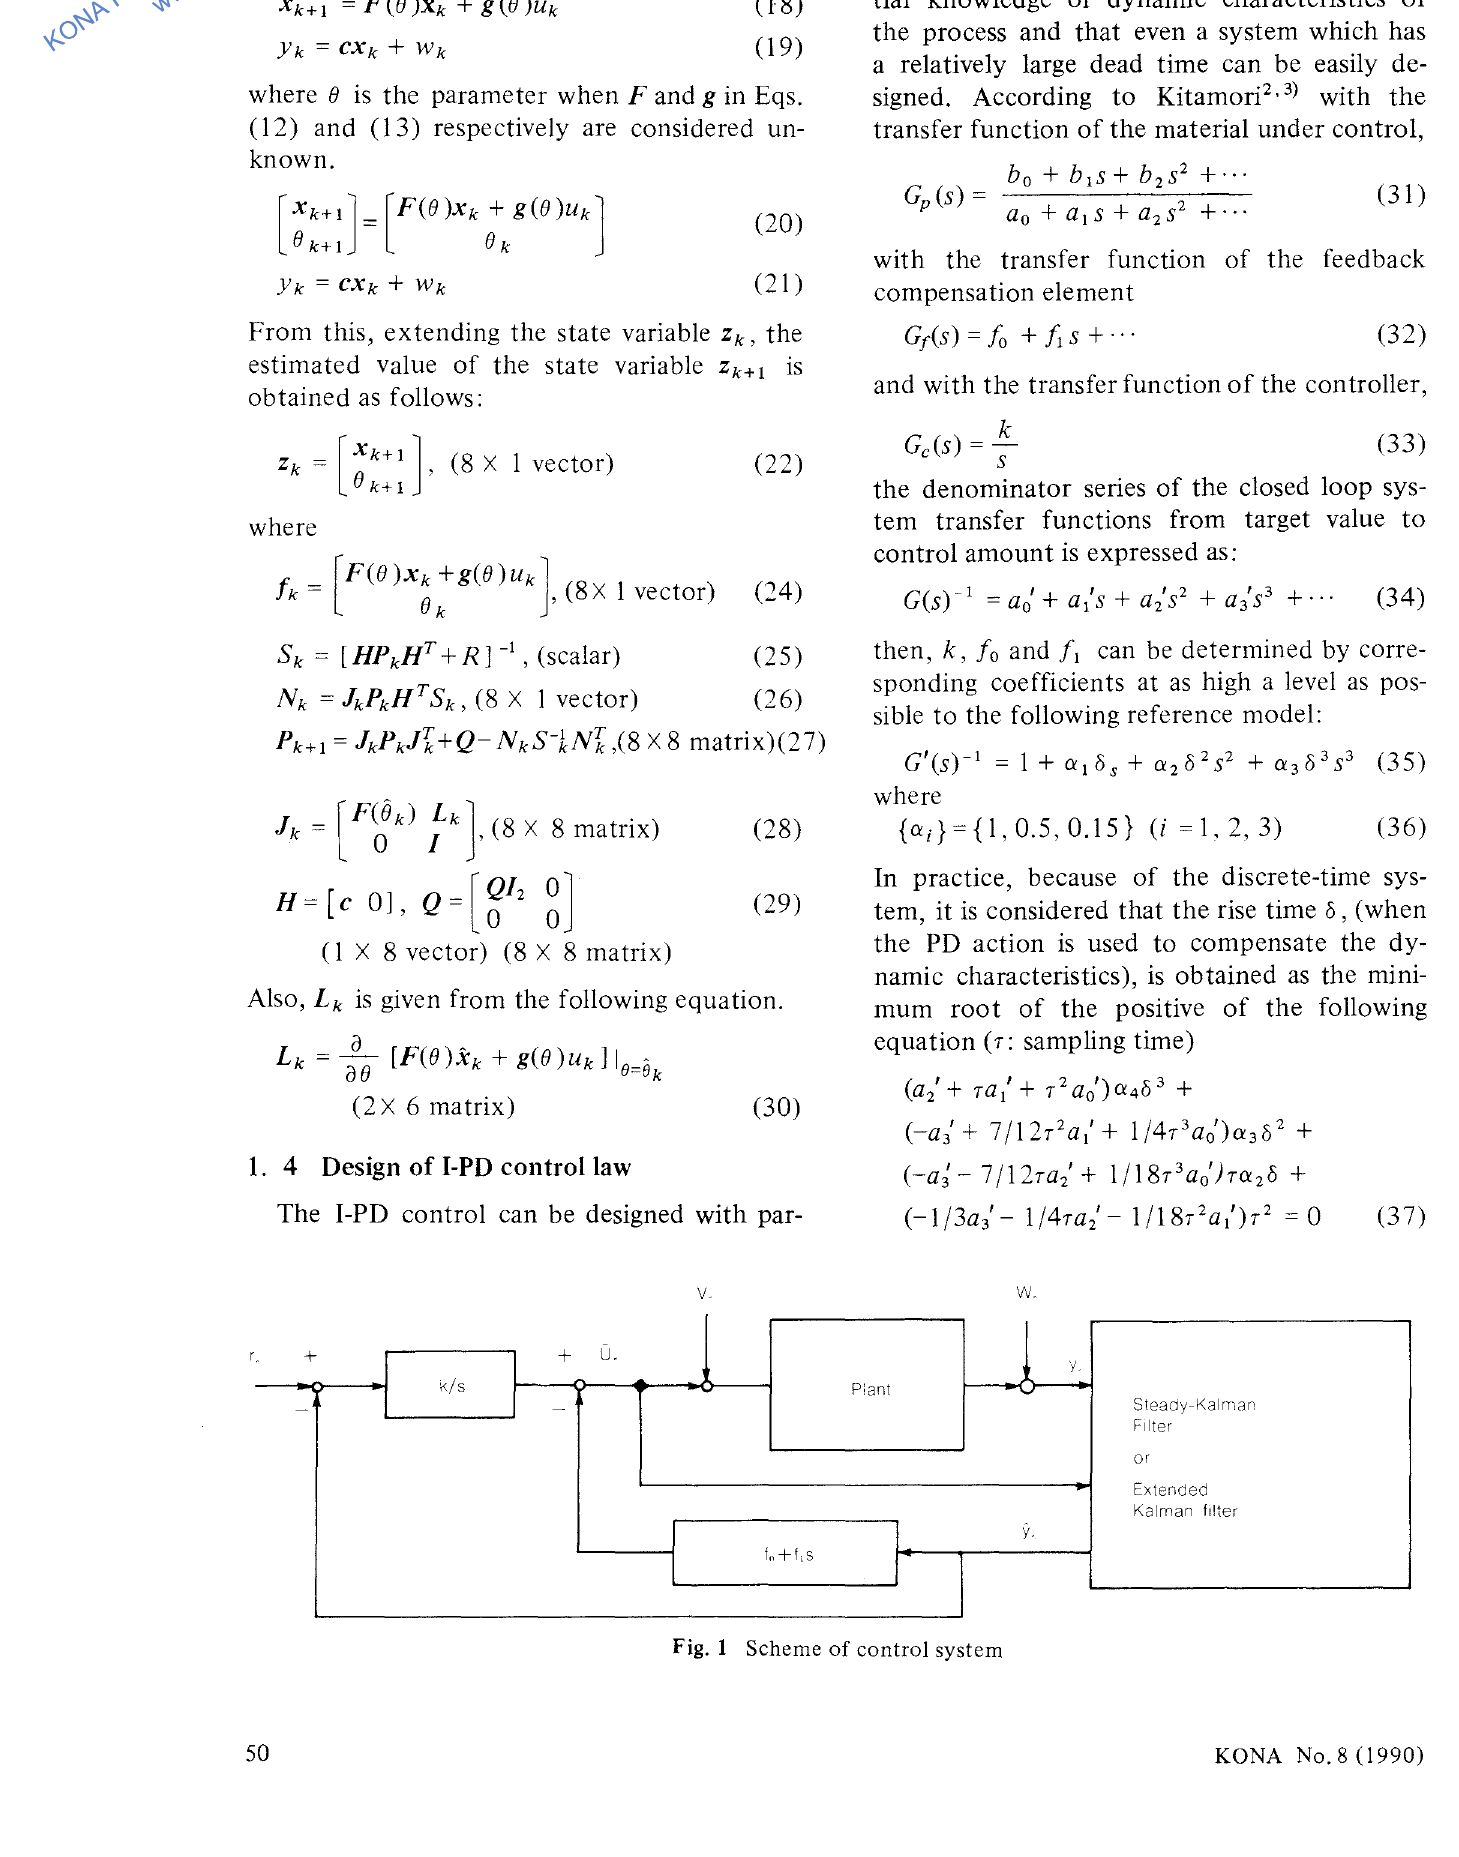
Fig. 1 Scheme of control